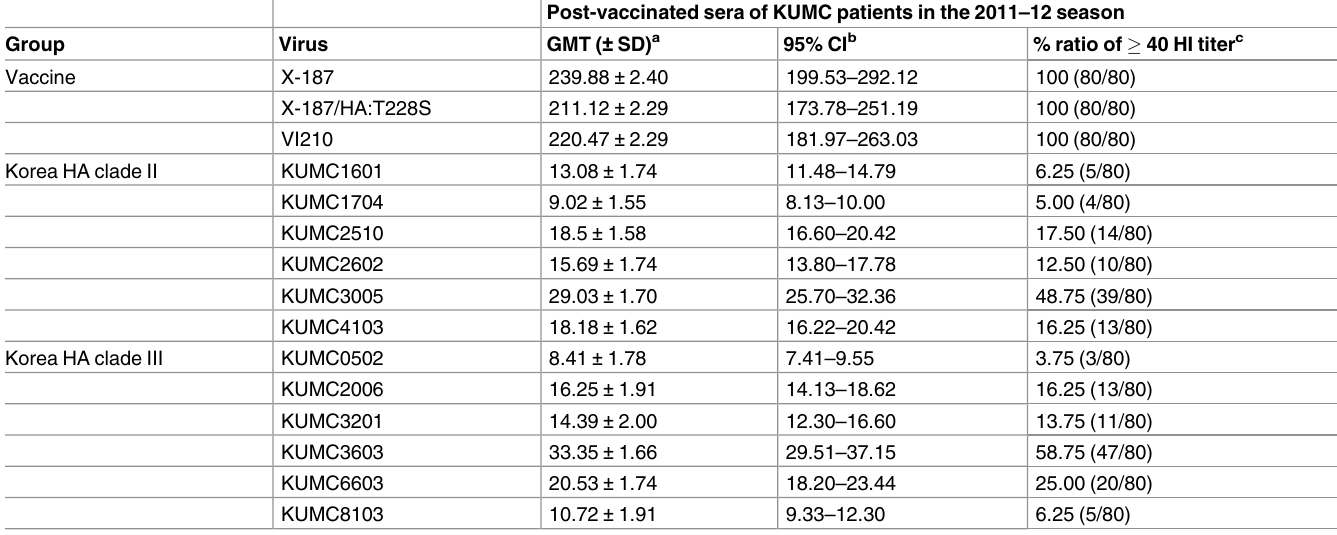
Table 1. HI-reactiveantibody titers of post-vaccinated patient sera of KUMC Guro Hospital.